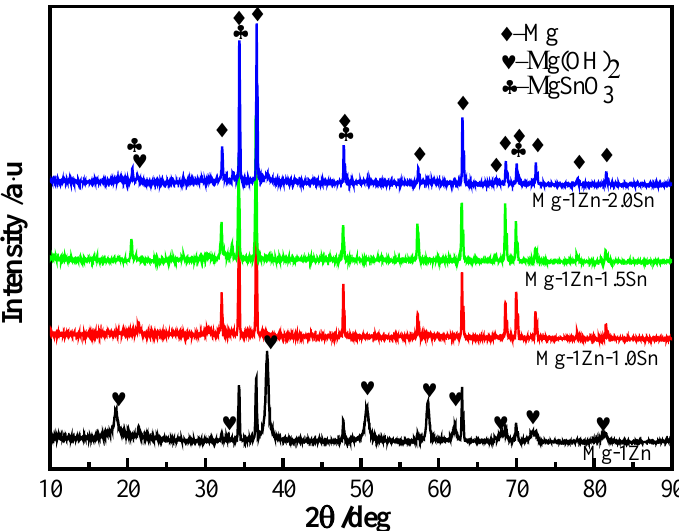
( d ) Figure 5. Immersion test results: hydrogen evolution ( a ), corrosion rate ( b ) by weight loss, and pH variation ( c ) of solution for Mg − 1Zn − xSn ternary alloys; degradation rate comparison ( d ) with some typical alloys. As a reduction in the degradation rate is always associated with the characteristics of the formed corrosion products, samples after seven days immersion were measured by XRD (Figure 6). It can be seen that the products are mainly Mg(OH) 2 . Additionally, MgSnO 3 appears in Sn-containing alloys. To clarify the formation process of the corrosion